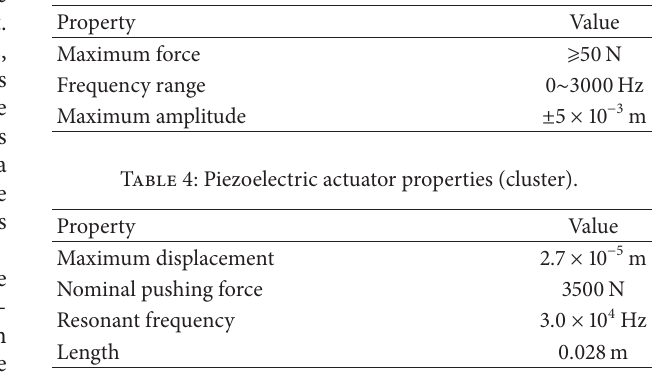
Figure 10: Cantilever beam response with PID control ON and OFF for fan stimulation. Table 3: Exciter characteristics.